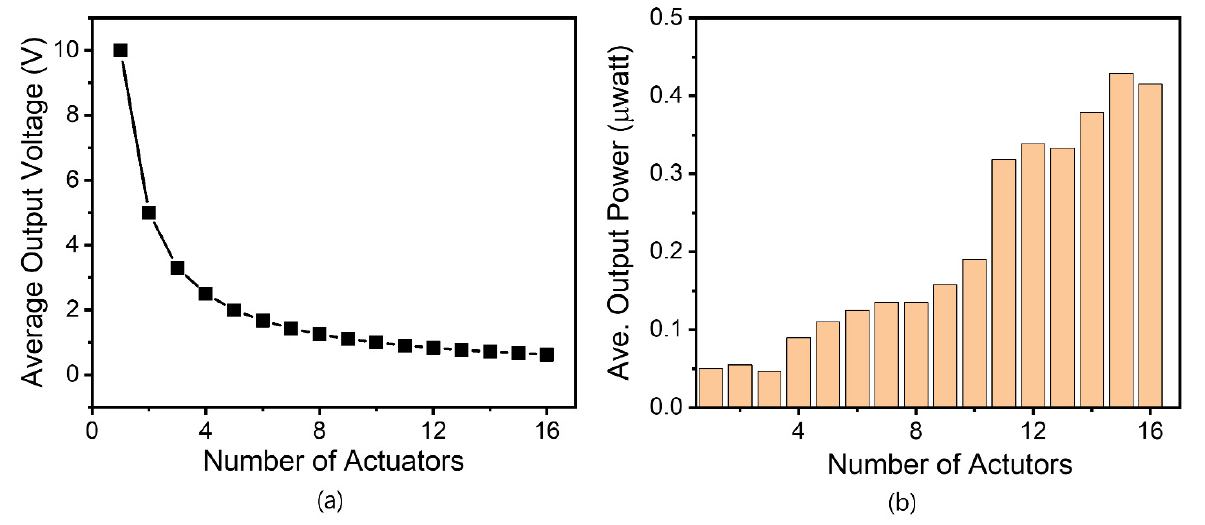
Figure 5. Performance of PD circuit for 16 actuators: (a) average output voltage for each actuator and (b) average output power for each actuator.